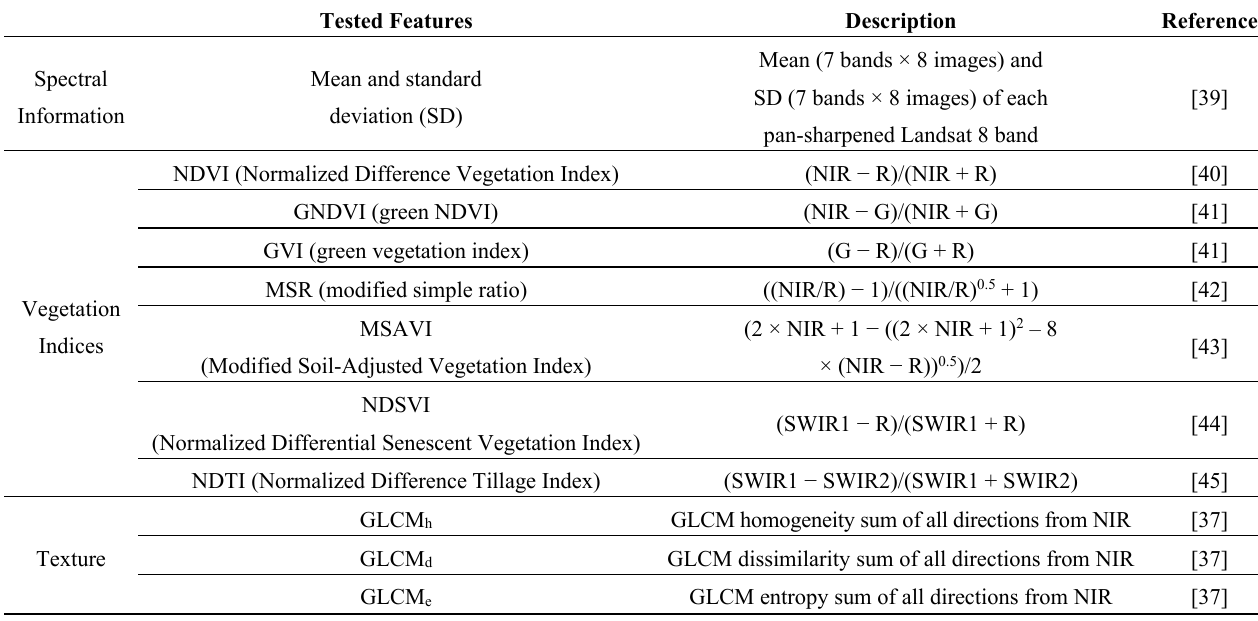
Table 3. Landsat 8 time series object-based features. GLCM, gray-level co-occurrence matrix; NIR, near-infrared; SWIR, shortwave infrared; R, red band; G, green band; B, blue band.